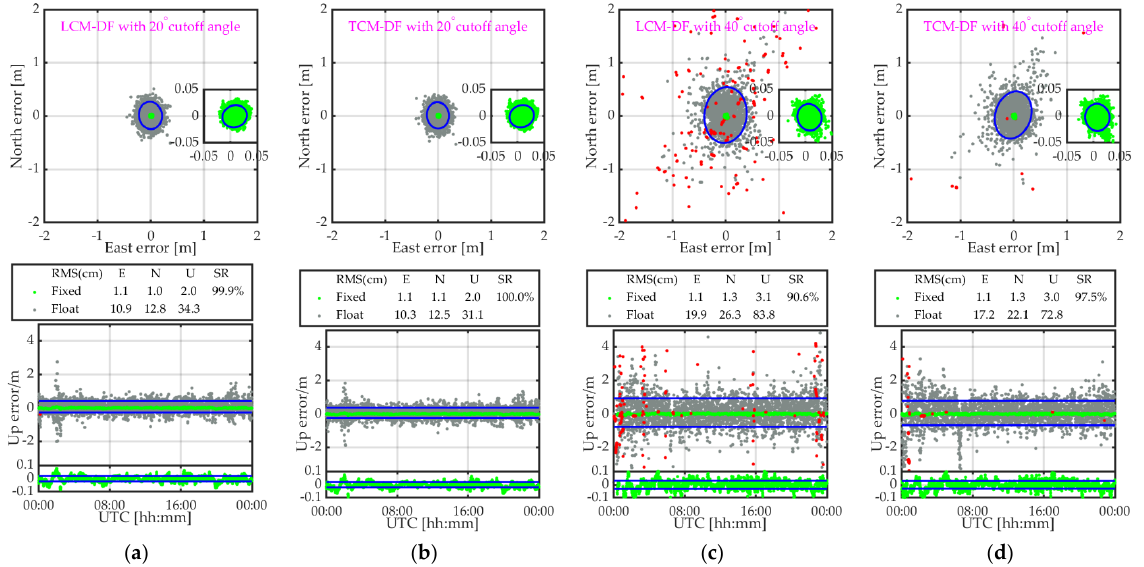
Figure 8. Horizontal scatters ( top ) and vertical time series ( bottom ) of the positioning errors of loosely-combined model (LCM) ( a , c ) and tightly-combined model (TCM) ( b , d ) DF RTK of baseline GODE-USN7 on DOY 120, 2021 with a cutoff elevation angle of 20° ( a , b ) and 40° ( c , d ). On the right of the horizontal scatterplot and on the bottom of the vertical time series, details are provided about the fixed solutions with the 95% confidence interval. The float solutions, correct solutions, and incorrect solutions are indicated in grey, green, and red, respectively.